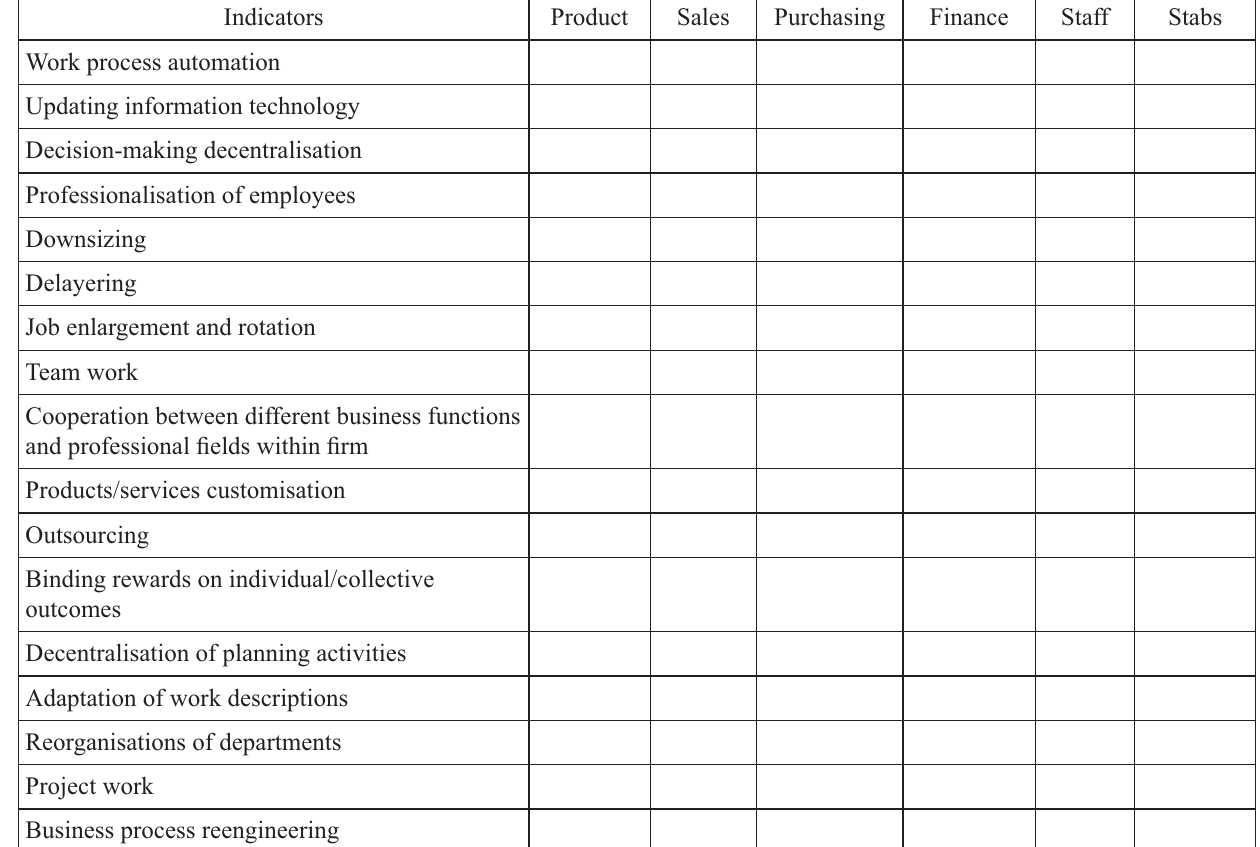
Table 1. Organisational structure adaptations indicator Indicators Product Sales